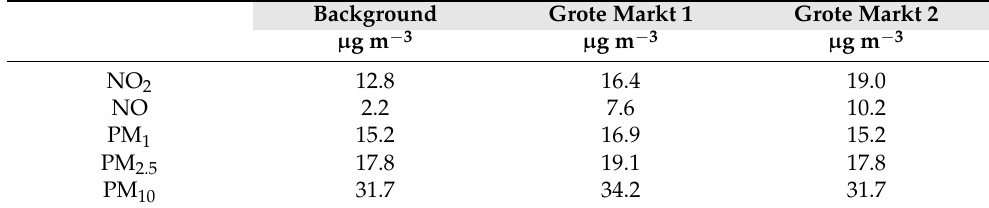
Table 4. Average NO 2 , NO, PM 1 , PM 2.5 and PM 10 concentrations exhibited during the pilot campaign in